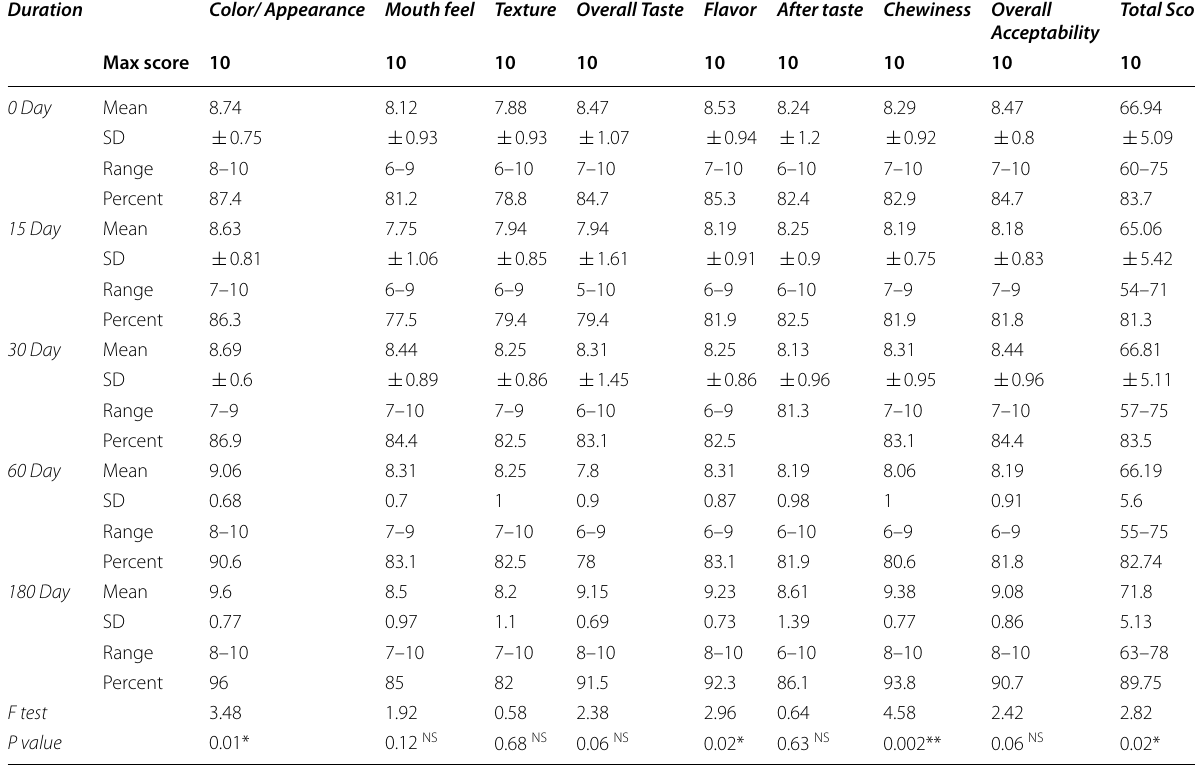
NS Non significant, 0.05-*,